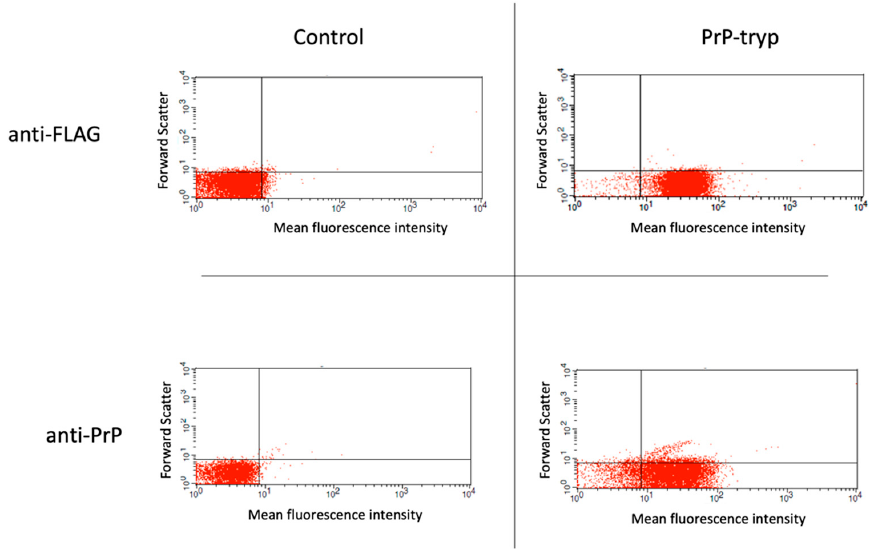
Figure 1. Flow cytometry to identify trypanosomes expressing the engineered variable surface glycoprotein (VSG). Following selection, stably transfected (PrP-tryp) and control (untransfected) T. brucei clones were stained with an anti-FLAG and an anti-PrP (6H4) antibody. A T. brucei clone with robust expression of the surface tag and the PrP peptide was identified.